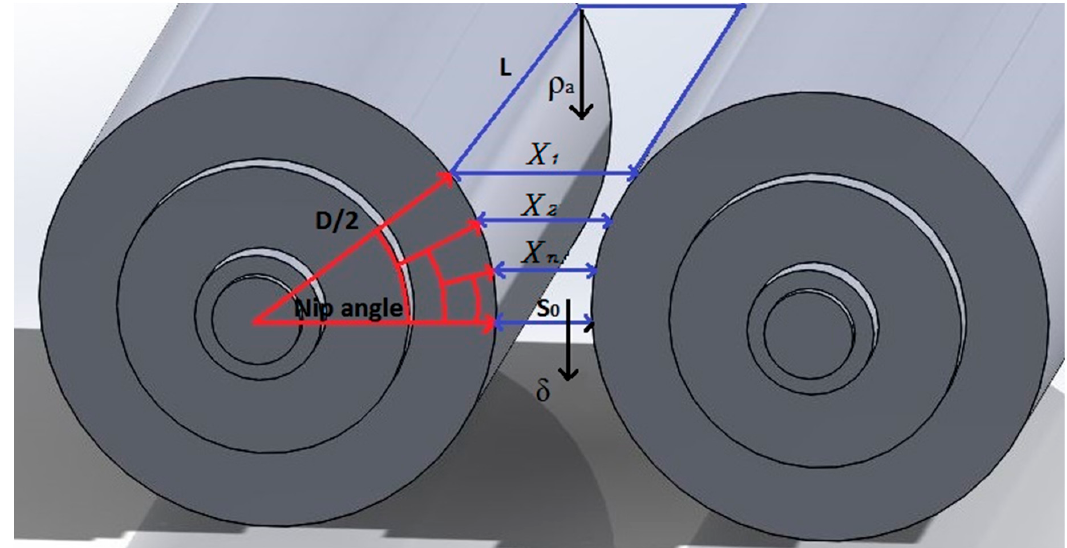
Figure 5. Calculation methodology for the parameter x n , which is necessary for the selection function.